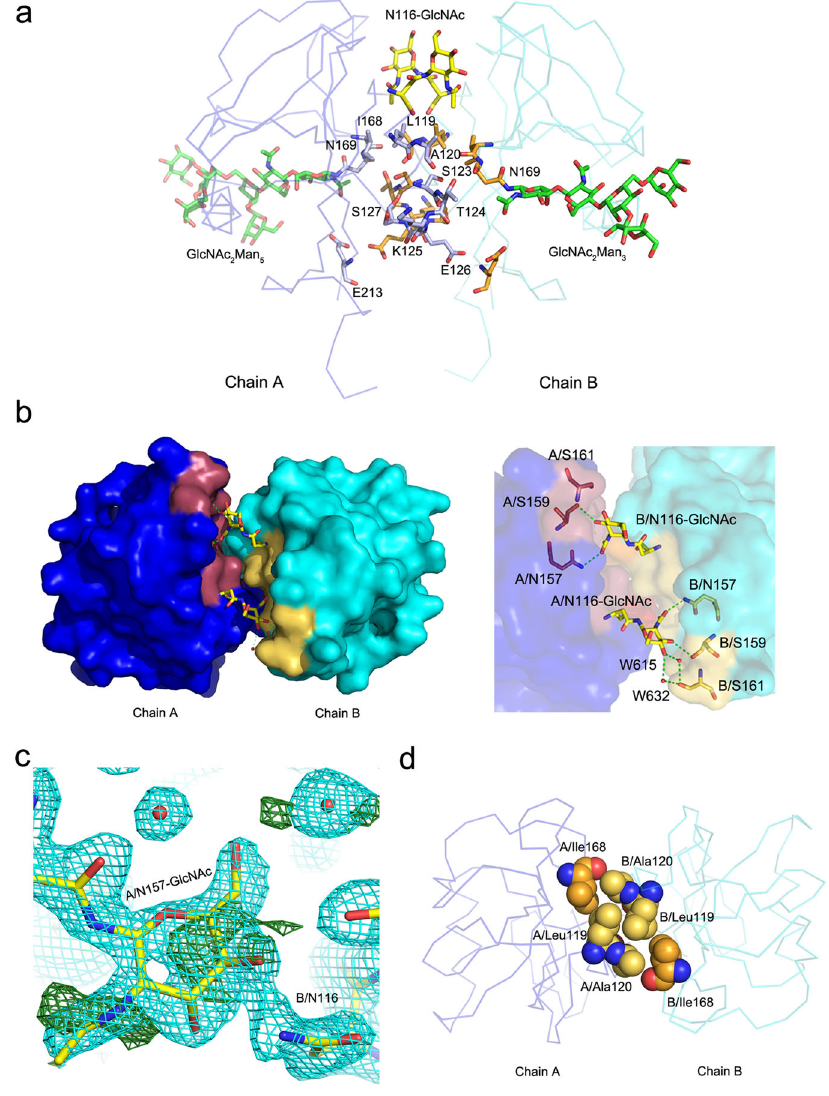
Fig. 3 | Glycosylation affects the dimerization interface of human NKR-P1. a DimerizationinterfaceofhumanNKR-P1.SubunitsofhumanNKR-P1areshownas C α -trace (blue and cyan), and the dimer contact residues are shown as sticks with carbon atoms colored in light blue (blue subunit) and orange (cyan subunit); for clarity, only the residues of the blue subunit are labeled. The fi rst GlcNAc unit N-linked to Asn116 and the carbohydrate chain N-linked to Asn169, observable in the NKR-P1_glyco structure, are shown with carbon atoms colored yellow and green, respectively. b Top view of the dimerization interface. The NKR-P1 subunits surfacesarecoloredblueandcyan.TheGlcNAcunitsboundtoAsn116areshownas stickswithcarbonatomsinyellow.ContactresiduesbetweentheGlcNAcboundto chainA,andthechainB,areshowninyellow,whereascontactresiduesbetweenthe